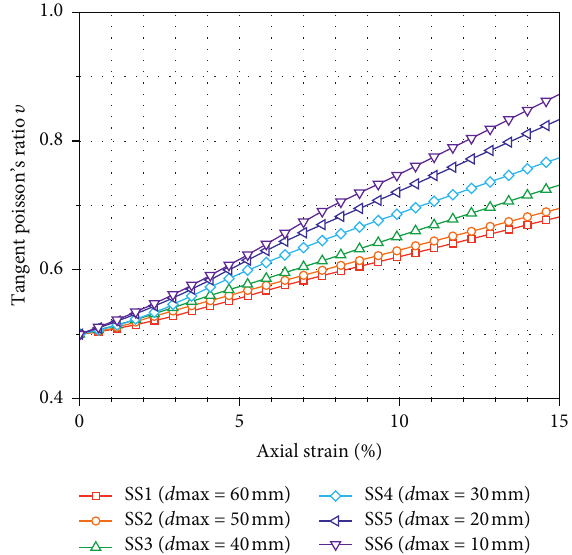
Figure 14: Tangent Poisson’s ratio-axial strain relationship curve for each scheme.